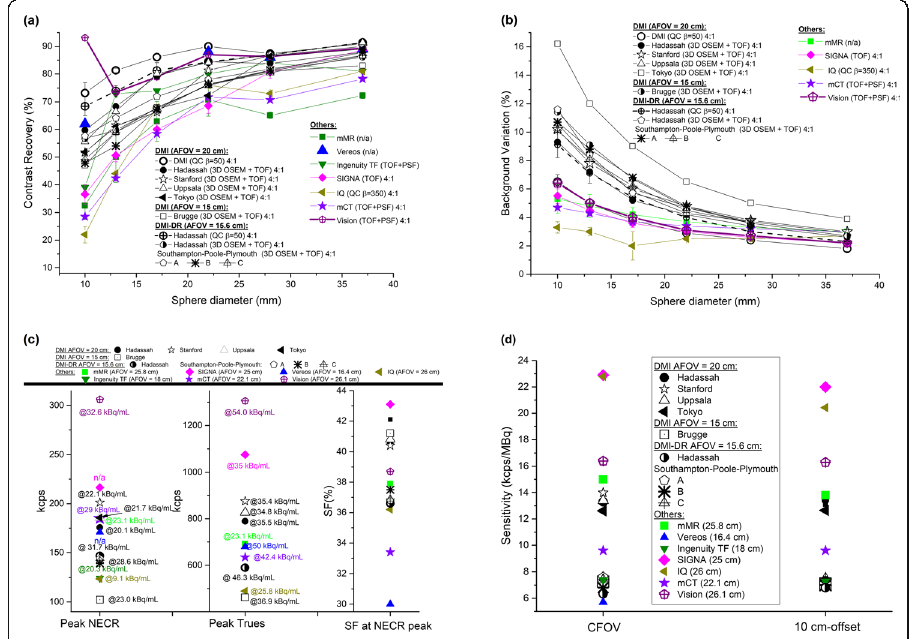
Fig. 7 a Contrast recovery (%), b background variability (%), c peak NECR, peak trues, scatter fraction at NECR peak, and corresponding activity concentrations and d sensitivity at CFOV and 10-cm radial offset